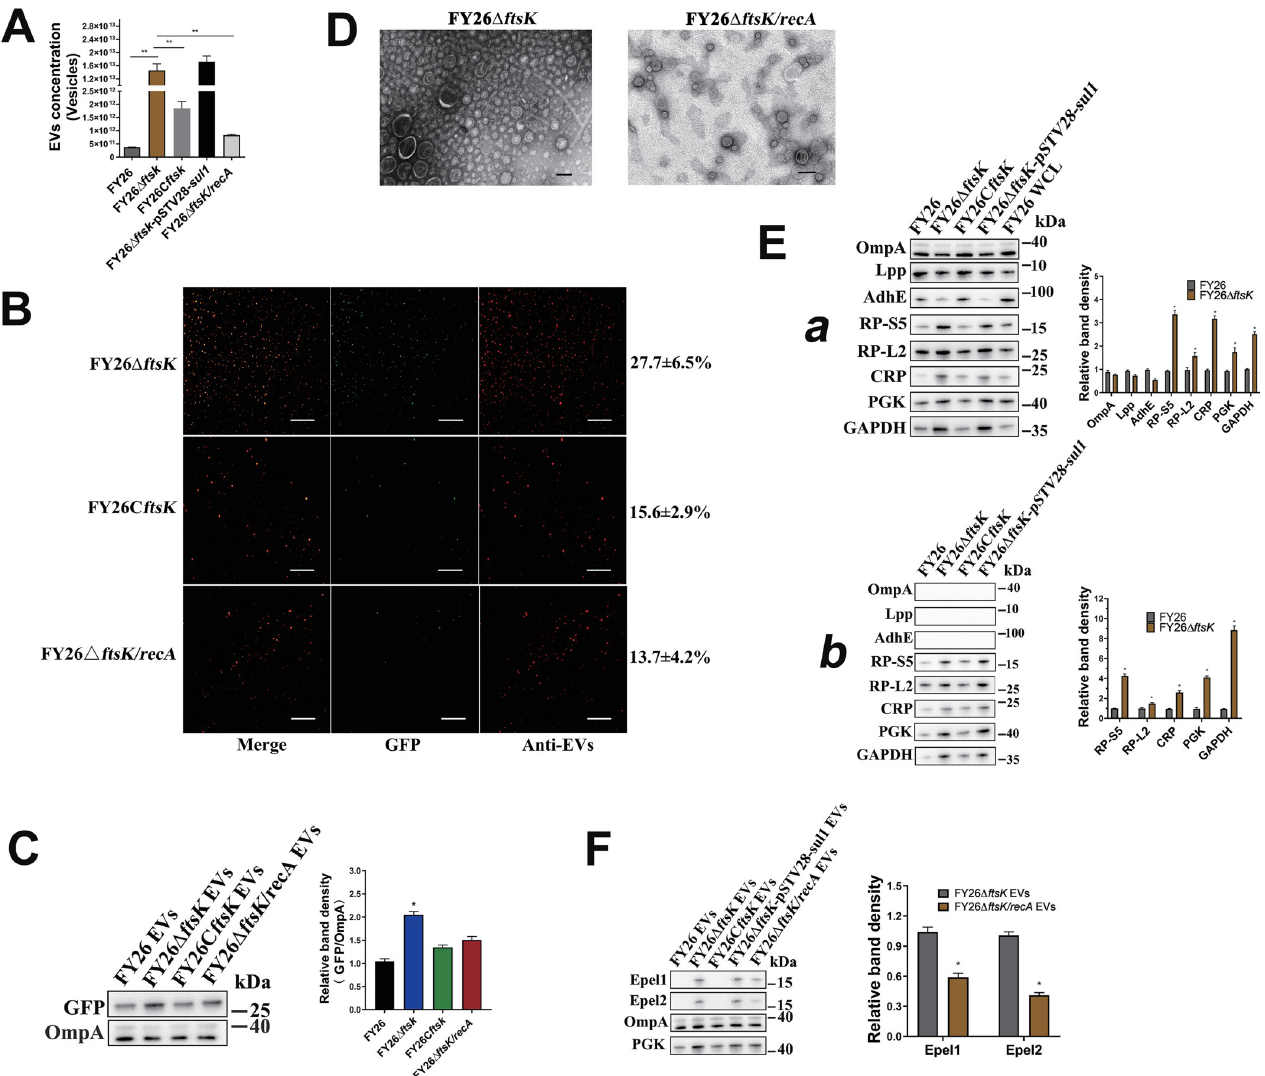
Fig 9. Deletion of ftsK gene increased the production of ExPEC cytoplasm-carrying vesicles. (A) The concentrations of EVs purified from FY26 Δ ftsK , FY26C ftsK and FY26 Δ ftsK / recA were determined with a nanoparticle tracking analysis (NTA). (B) Immunofluorescent staining of EVs produced by FY26 Δ ftsK , FY26C ftsK and FY26 Δ ftsK / recA .Percentage of cytoplasm-carrying vesicles (green fluorescence) among the total EVs (red fluorescence) is indicated on the right. Graph shows a representative image. Scale bars: 10 μ m. (C) GFP and OmpA proteins in EVs were determined with western blotting. (D) The EVs produced by FY26 Δ ftsK and FY26 Δ ftsK / recA were observed with transmission electron microscopy (TEM). Scale bars: 200 nm. (E) Levels of membrane and cytoplasmic proteins in EVs (a) and EV-free extracellular medium (b) from FY26 Δ ftsK and FY26C ftsK were determined with western blotting. (F) Protein levels of endolysins Epel1 and Epel2 variants in EVs of FY26 Δ ftsK and FY26 Δ ftsK / recA were determined with western blotting. recA was 13.7 ± 4.2%, approaching the original level in WT FY26 (Fig 9B). The expression level of GFP protein in the EVs of FY26 Δ ftsK / recA was similar to that in the WT FY26 (Fig 9C). TEM images showed that the vesicles produced by mutant FY26 Δ ftsK / recA predominantly included single-layered vesicles (Fig 9D). The transcription of epel1 , epel2 . 1 , and epel2 . 2 in the mutant FY26 Δ ftsK was determined with qRT-PCR. The results indicated that the transcription levels of epel1 , epel2 . 1 , and epel2 . 2 in FY26 Δ ftsK were clearly increased about 7.9-fold, 8.6-fold, and 8.9-fold, respectively, at 12 h ( P � 0.01) (S10C Fig). However, the transcription levels of these endolysin genes were significantly decreased in FY26 Δ ftsK / recA (S10C Fig). The protein